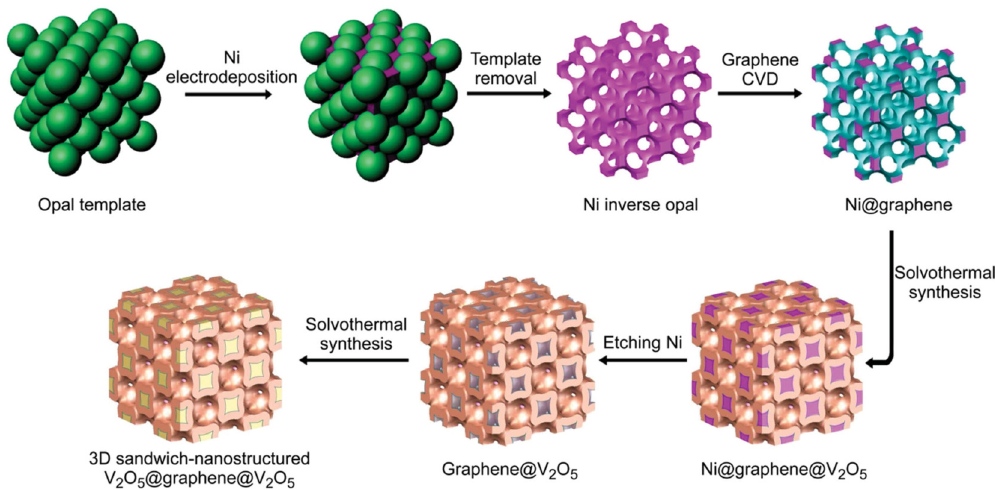
Figure 6. Schematic illustration for the fabrication of the 3D sandwich-structured V 2 O 5 @graphene@V 2 O 5 @V 2 O 5 cathode. Reproduced with permission from [34]. Wiley, cathode. Reproduced with permission from [34]. Wiley, 2016.